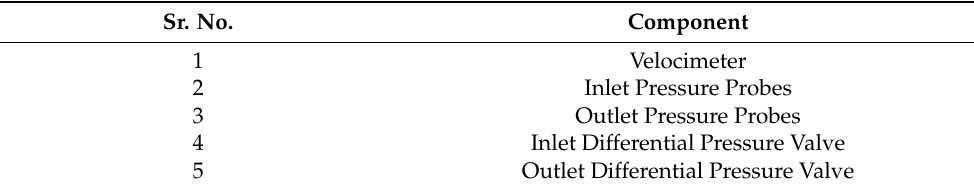
Table 1. Component list for pressure testing in subsonic wind